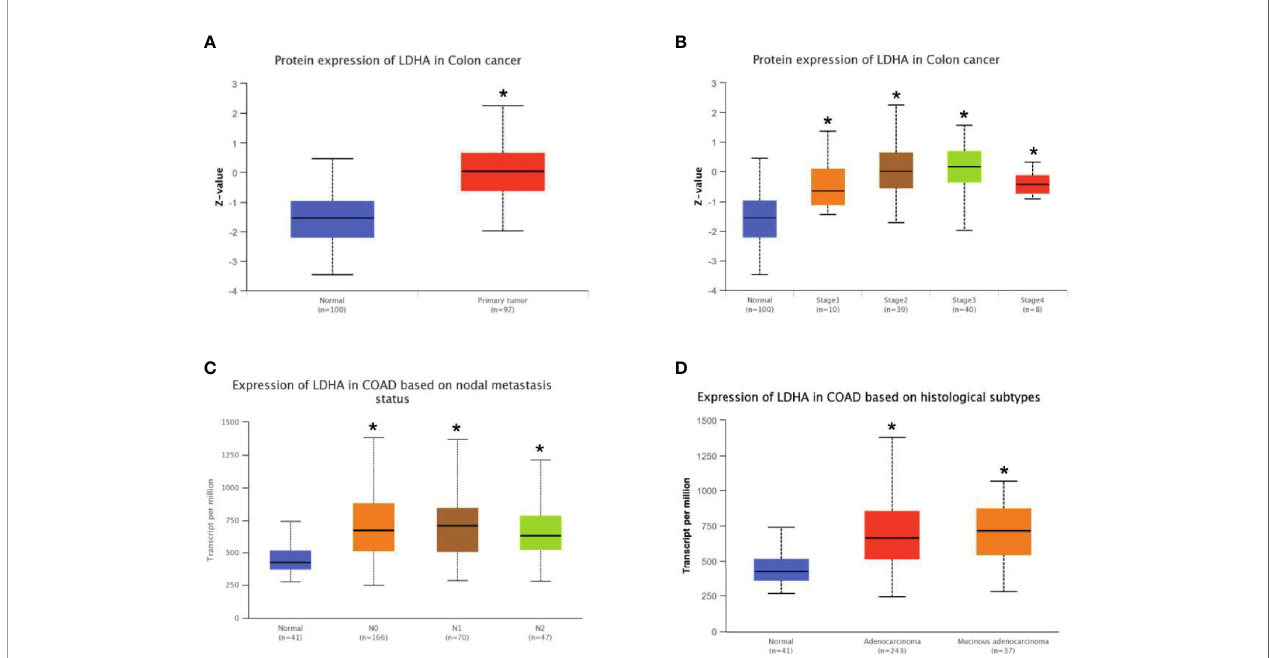
FIGURE 2 | Correlation of LDHA expression and clinicopathological features of COAD was analyzed using the online database UALCAN. (A) Box plot shows expression of LDHA in COAD and normal patients. (B) Box plot shows relative expression of LDHA in normal individuals or in COAD patients in stages 1, 2, 3, or 4. (C) Box plot shows relative expression of LDHA in normal individuals or in COAD patients in N stages 0, 1, or 2. (D) Box plot shows relative expression of LDHA in normal individuals or in adenocarcinoma or mucinous adenocarcinoma COAD patients. * p < 0.05 compare with control.